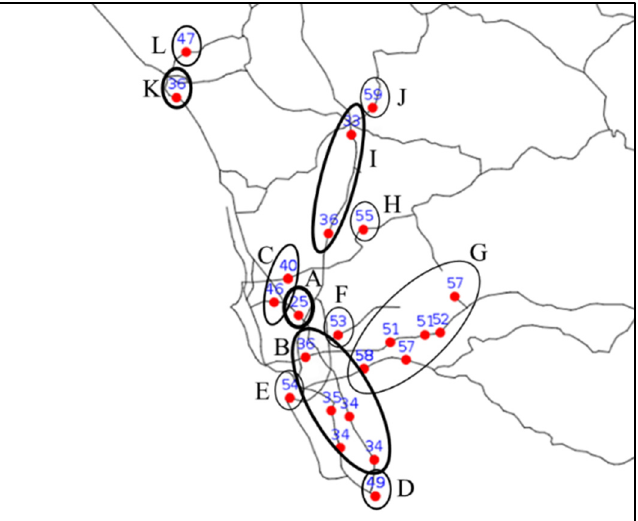
Figure 22. The KFCx influence score (the numbers within the figure) necessary for the optimal store location identified by proposed approach query matches real-world KFC branch. location identified by proposed approach query matches real-world KFC